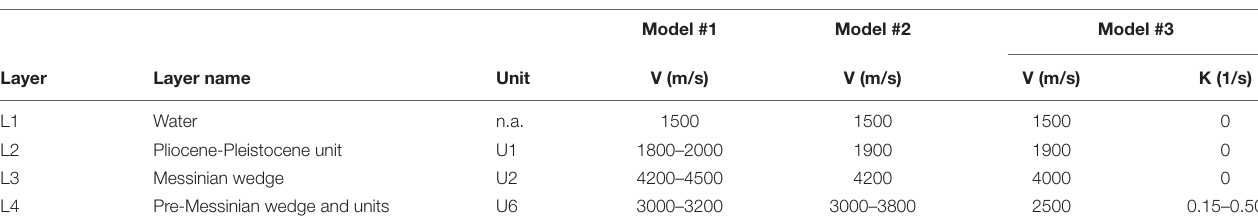
TABLE 3 | Velocity